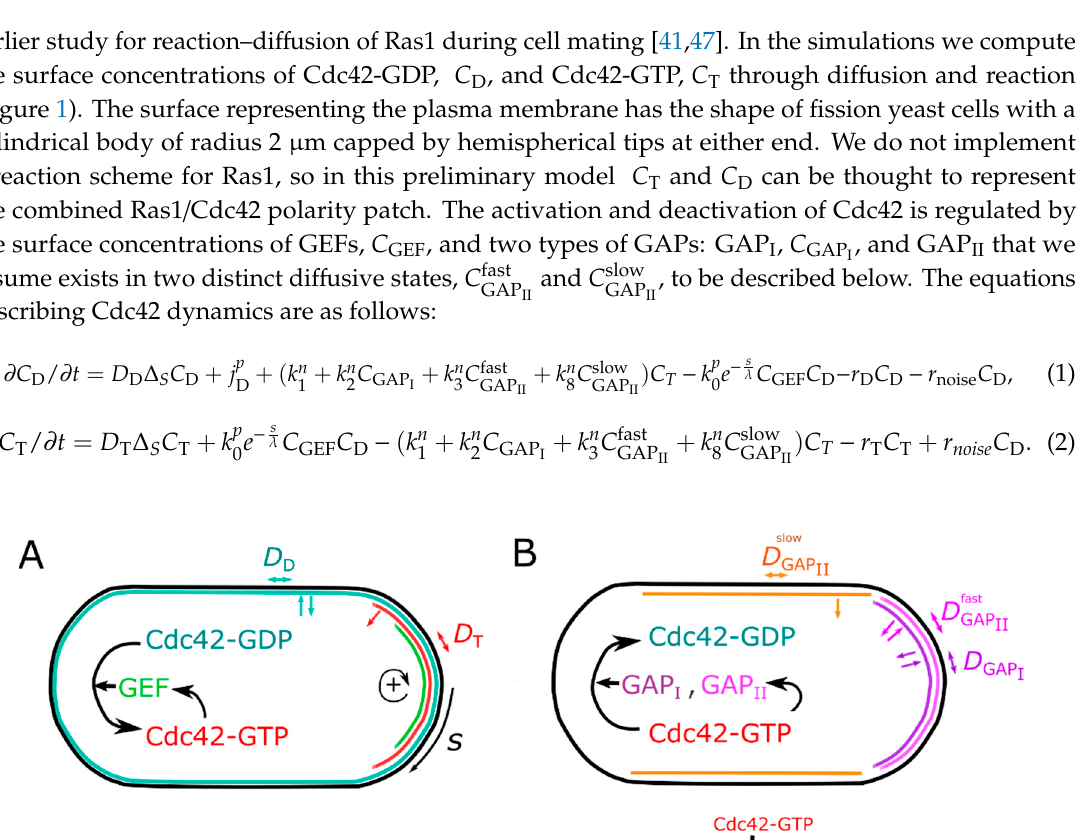
positive feedback at cell tips, with colored regions indicating zones of active Cdc42-GTP patch. The